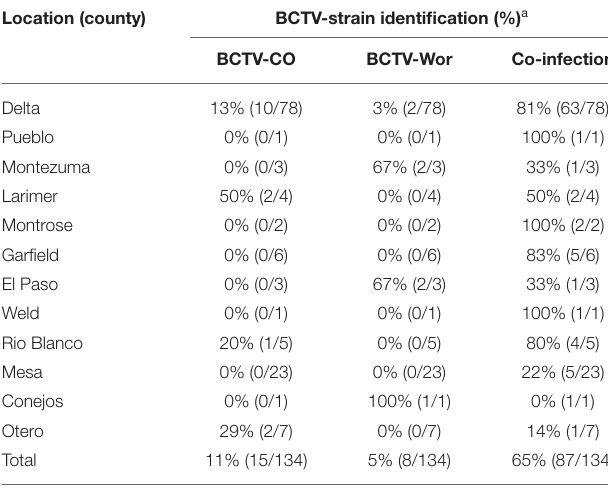
FIGURE 1 | Incidence of beet curly top virus (BCTV) in hemp leaf samples collected during the 2019 field season in Colorado as determined by PCR analysis. Incidence was calculated as number of BCTV-positive hemp leaf tissue samples over total samples tested per county listed in Table 2 .